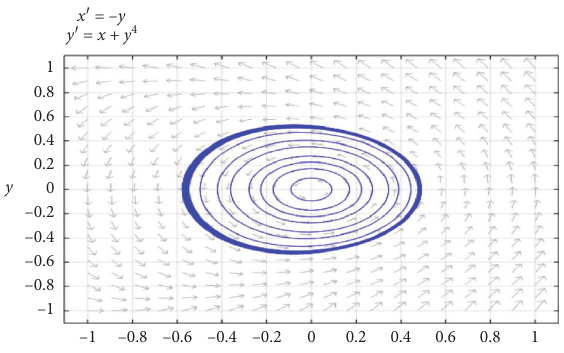
Figure 4: Existence of limit cycle of system (6), when k � 0 . 2 , l � − 0 . 2 , m � − 0 . 06 , and n � 1.